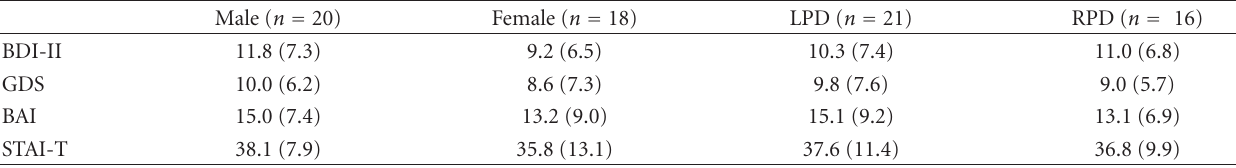
Table 2: Anxiety and depression symptoms in PD subgroups by gender and side of motor symptom